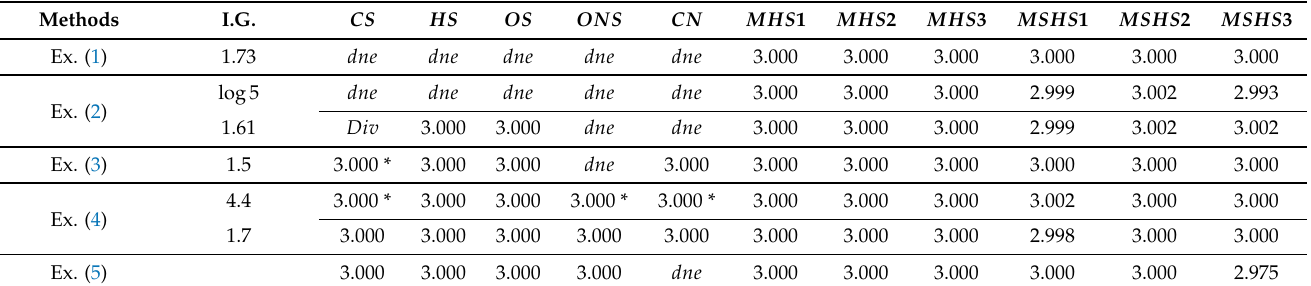
Table 3. Contrast of distinct iterative methods based on Computational order of convergence. * stands for convergence to undesired